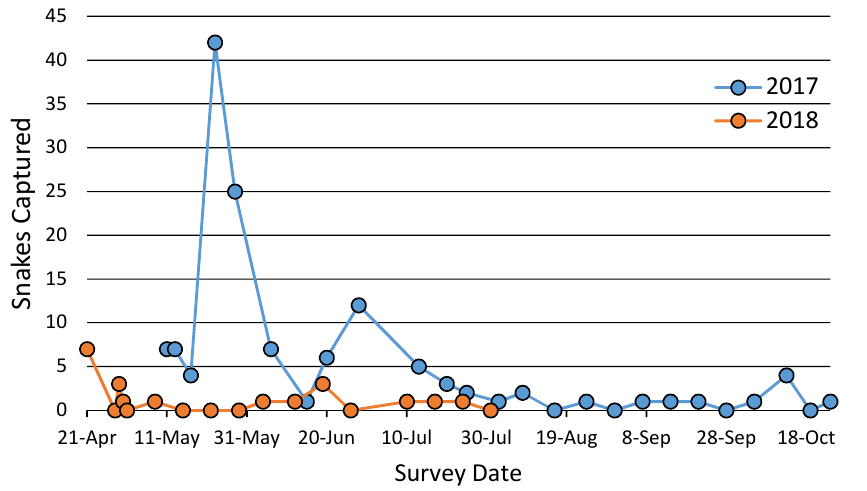
Figure 1. Clonophis kirtlandii captures over time from coverboard surveys. A peak in snake captures was observed on 23 May 2017. No peak in snake activity occurred in 2018.